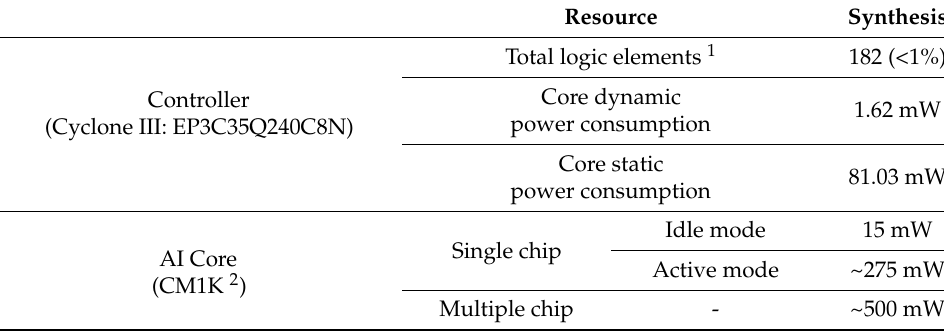
Table 1. Resource utilization of the AI